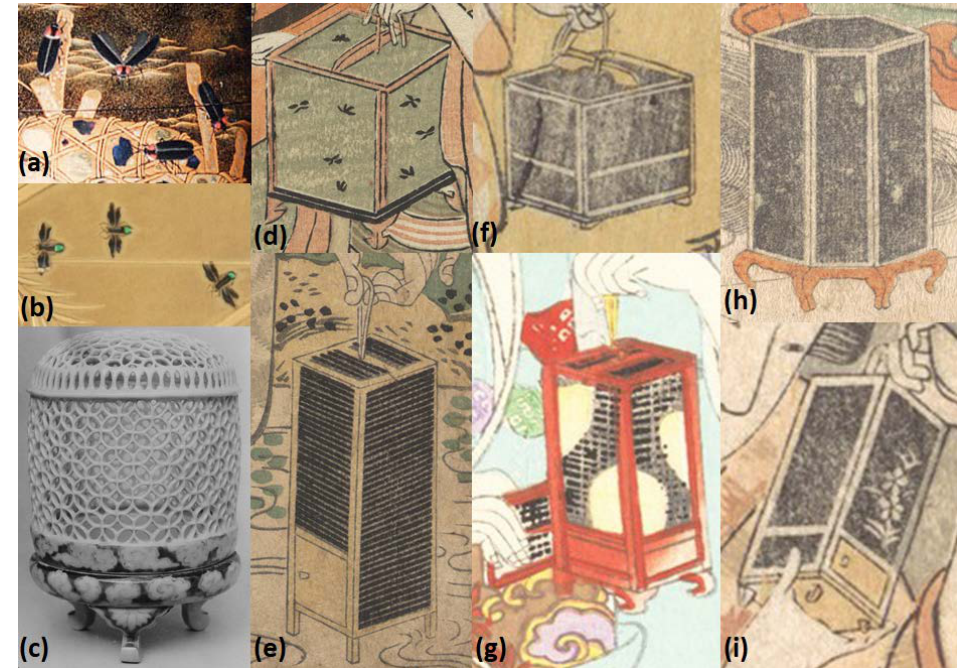
Figure 8. Examples of fireflies and firefly cages: ( a ) detail from Figure 1, ( b ) detail from T163, ( c ) T65 (cropped), ( d ) detail from Figure 6 (T2), ( e ) detail from Figure 3a (T16), ( f ) detail from Figure 5 (T186), ( g ) detail from Figure 4 (T12), ( h ) detail from Figure 7 (T41), ( i ) detail from Figure 5 (T186). The Metropolian Museum of Art, New York, NY, USA, www.metmuseum.org (accessed on 4 January 2022). Open access images, CC0.